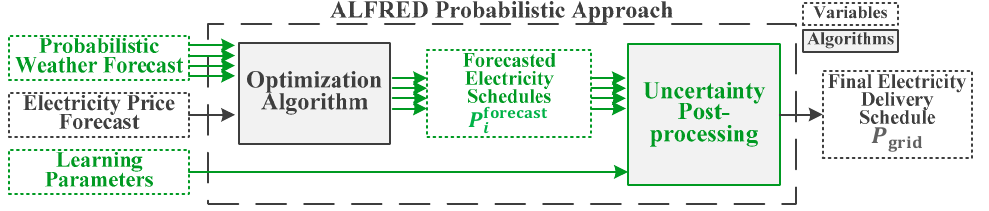
Figure 3. ALFRED probabilistic dispatch planning tool. The aspects in which adaptations are implemented for this approach are highlighted in green.